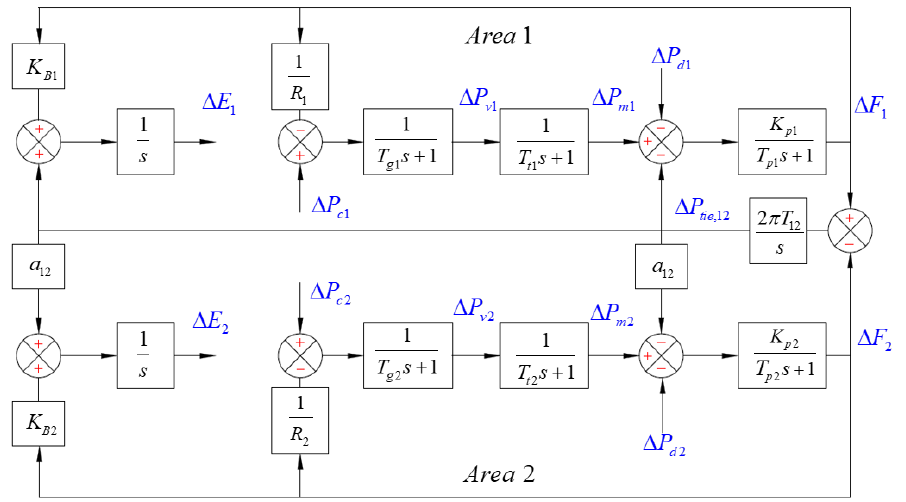
Figure 1. Schematics of TAPS interconnection.